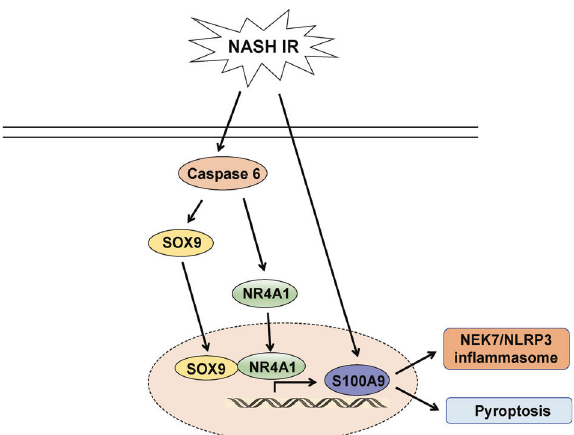
Fig. 8 The schematic fi gure depicts putative molecular mechan- isms in Caspase 6-mediated in fl ammation induced by IR in fatty liver. Caspase 6 controls NR4A1-SOX9 interaction to drive liver in fl ammatory response. Speci fi cally, SOX9 acts as a coactivator of NR4A1 to target the downstream gene S100A9, a key regulator of NEK7/NLRP3 in fl ammasome activation and